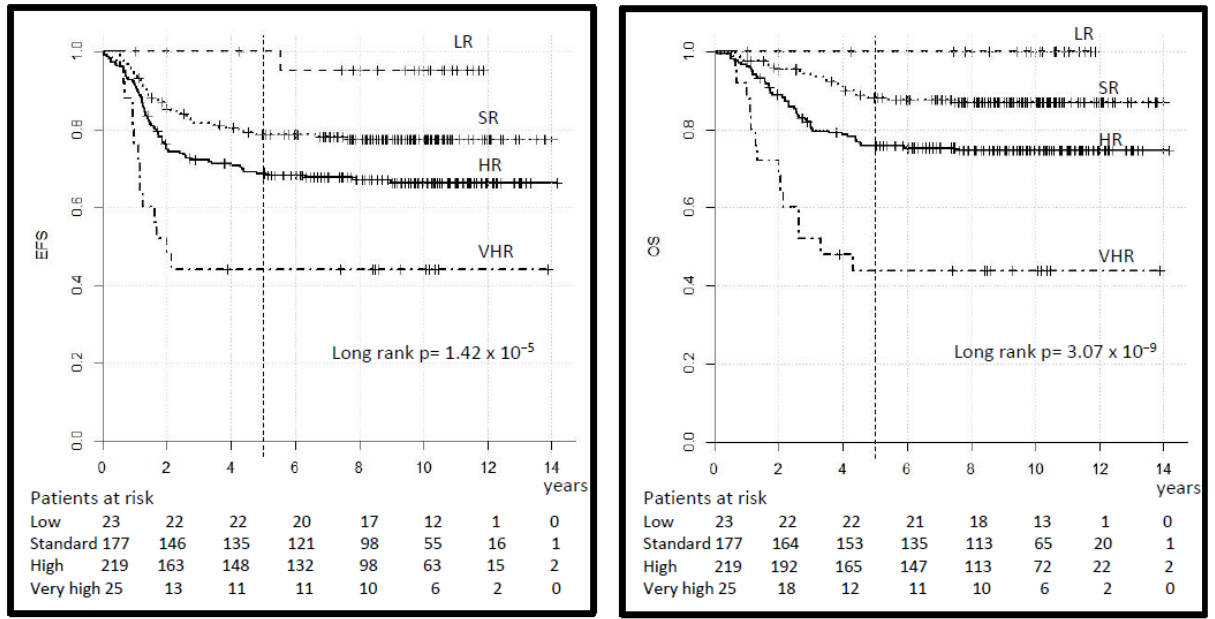
Figure 4. Legend: event-free and overall survival (EFS and OS) by risk group.